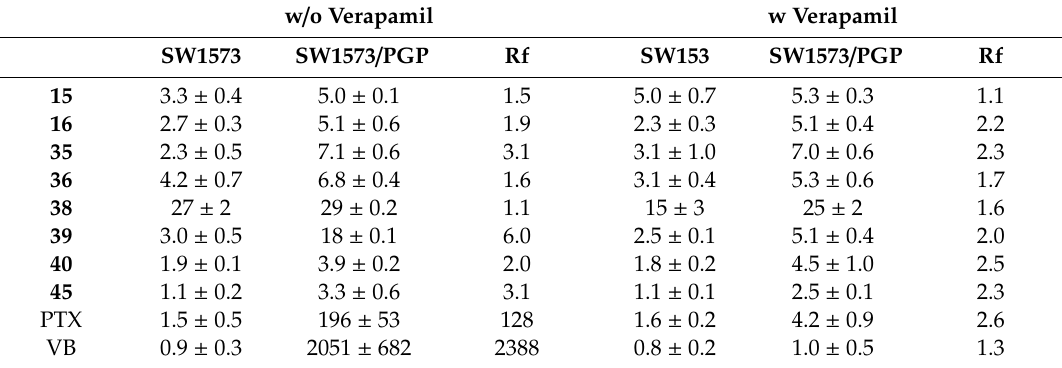
Table 4. Antiproliferative activity (GI 50 ) of organochalcogen derivatives in SW1573 and SW1573 / P-gp cell lines 1